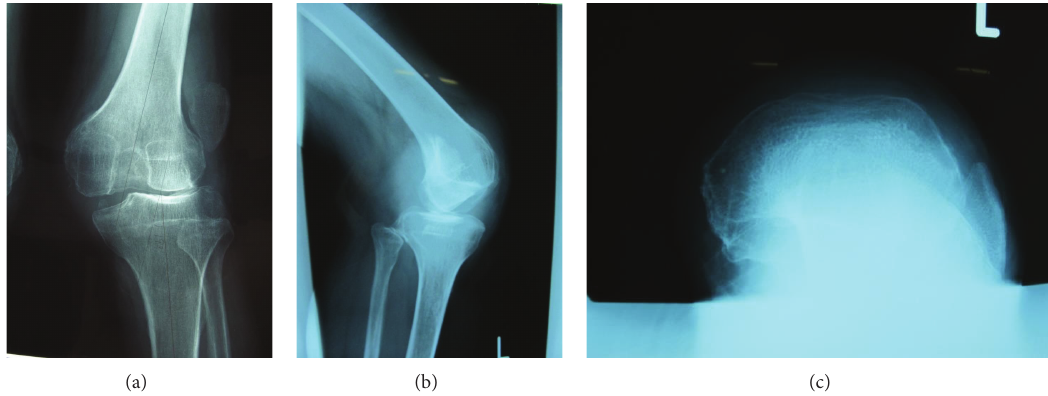
Figure 1: Preoperative radiographs: anteroposterior view (a), lateral view (b), and skyline view (c) of left knee.